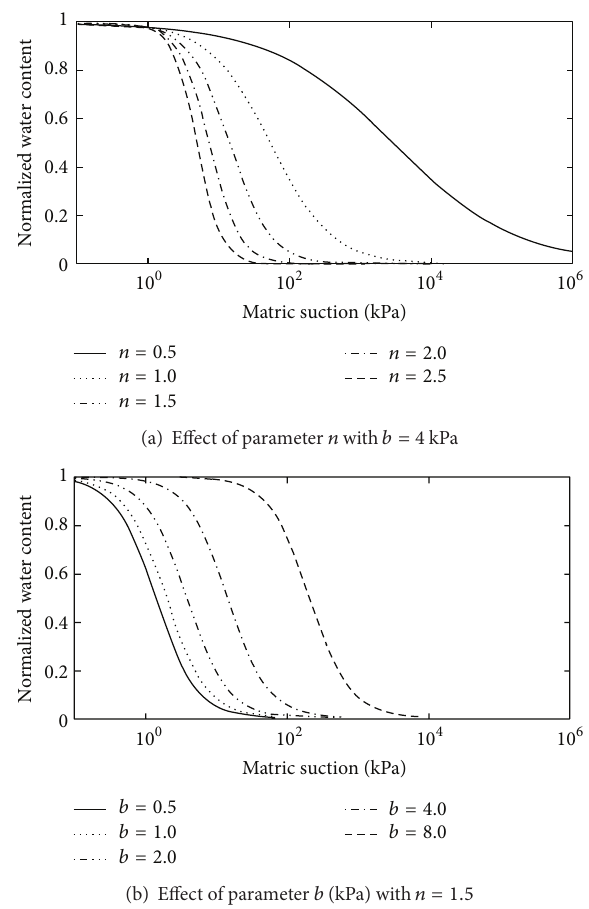
Figure 1: Effect of parameters 𝑛 and 𝑏 on the shape of the soil-water characteristic curve of the modified Gardner model.